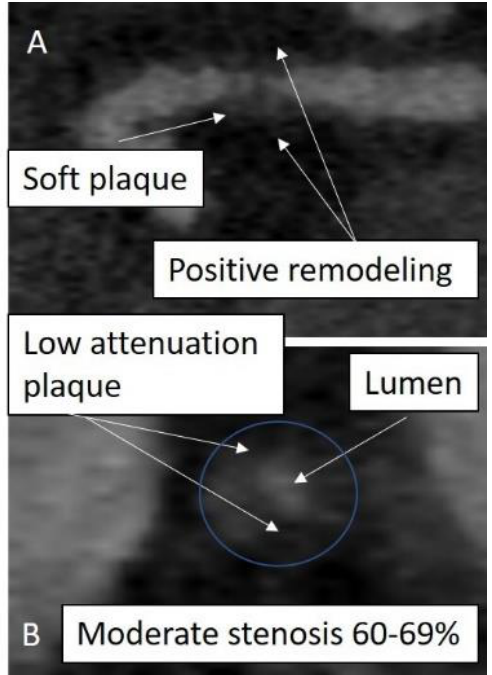
Figure 2. Subclinical atherosclerosis. Coronary CT angiogram (CCTA) of a patient undergoing cardiac CT prior to pulmonary vein ablation therapy. CAC was zero. A subclinical 50% stenosis was detected in the proximal left anterior descending artery (LAD) with features suggestive of an unstable plaque. Multiplanar reformatted images are shown in long axis (panel ( A )) and short axis (panel ( B )).